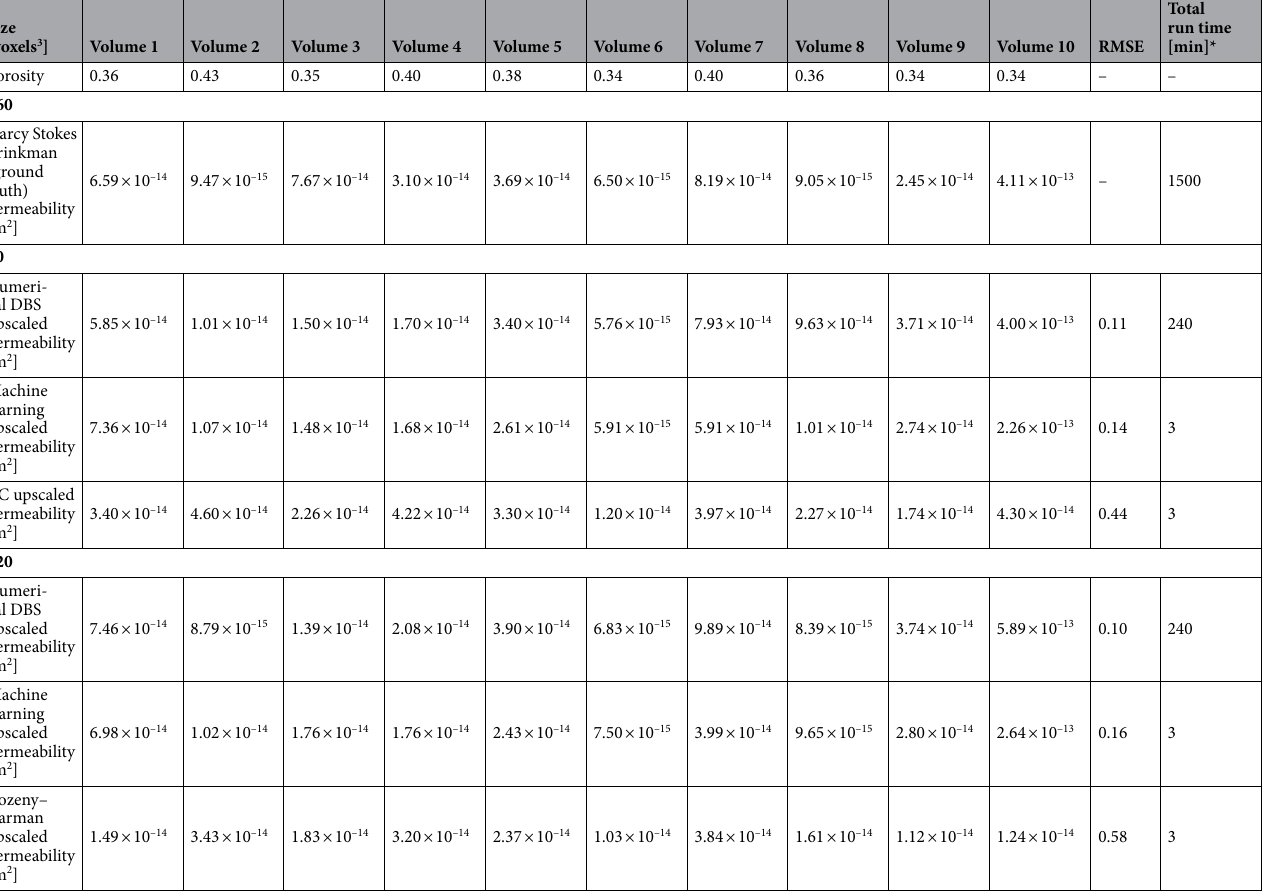
Table 2. Results for 360 3 Darcy blocks. *All model run times are for a 24 CPU workstation and summed across all